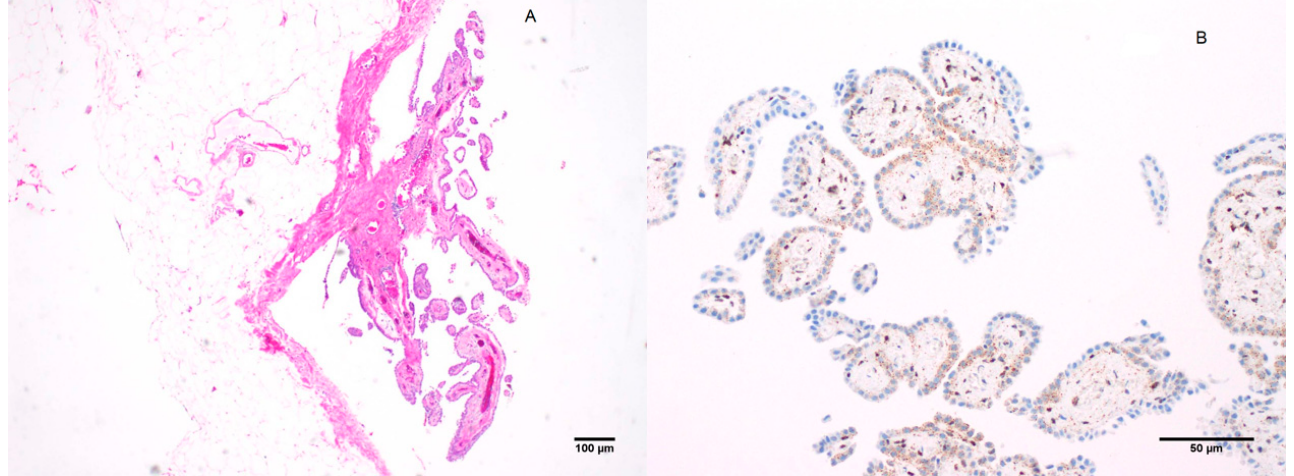
Figure 1. Well-differentiated papillary mesothelial tumour. WDPMT characterised by a papillary lesion with broad papillae and bland surface mesothelium. ( A ) H&E (Hematoxylin-Eosin stain) 4× magnification; ( B ) BAP1 IHC 20× magnification (retrospectively performed).